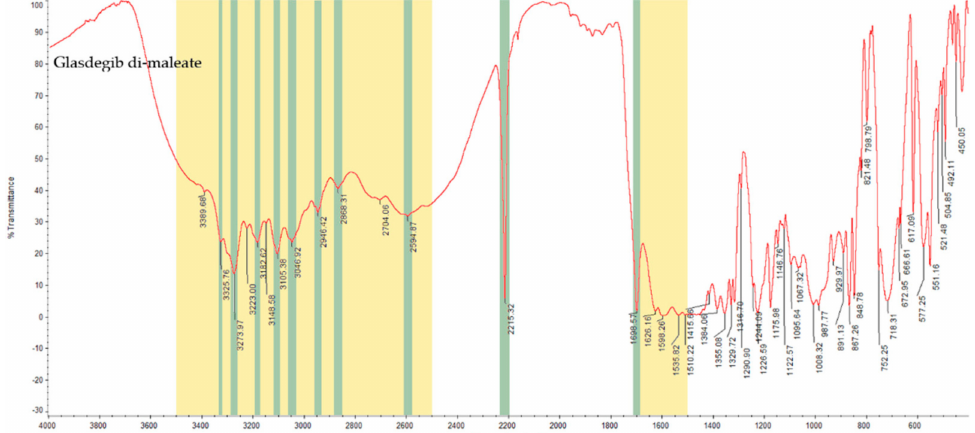
Figure 4. IR spectrum of glasdegib dimaleate with highlighted diagnostic regions and bands.